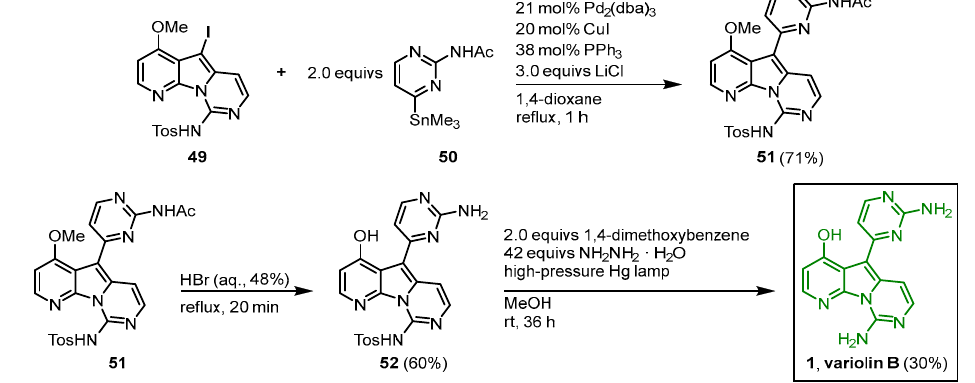
Figure 10. Synthesis of variolin B ( 1 ) via Stille coupling as a key reaction step [47].